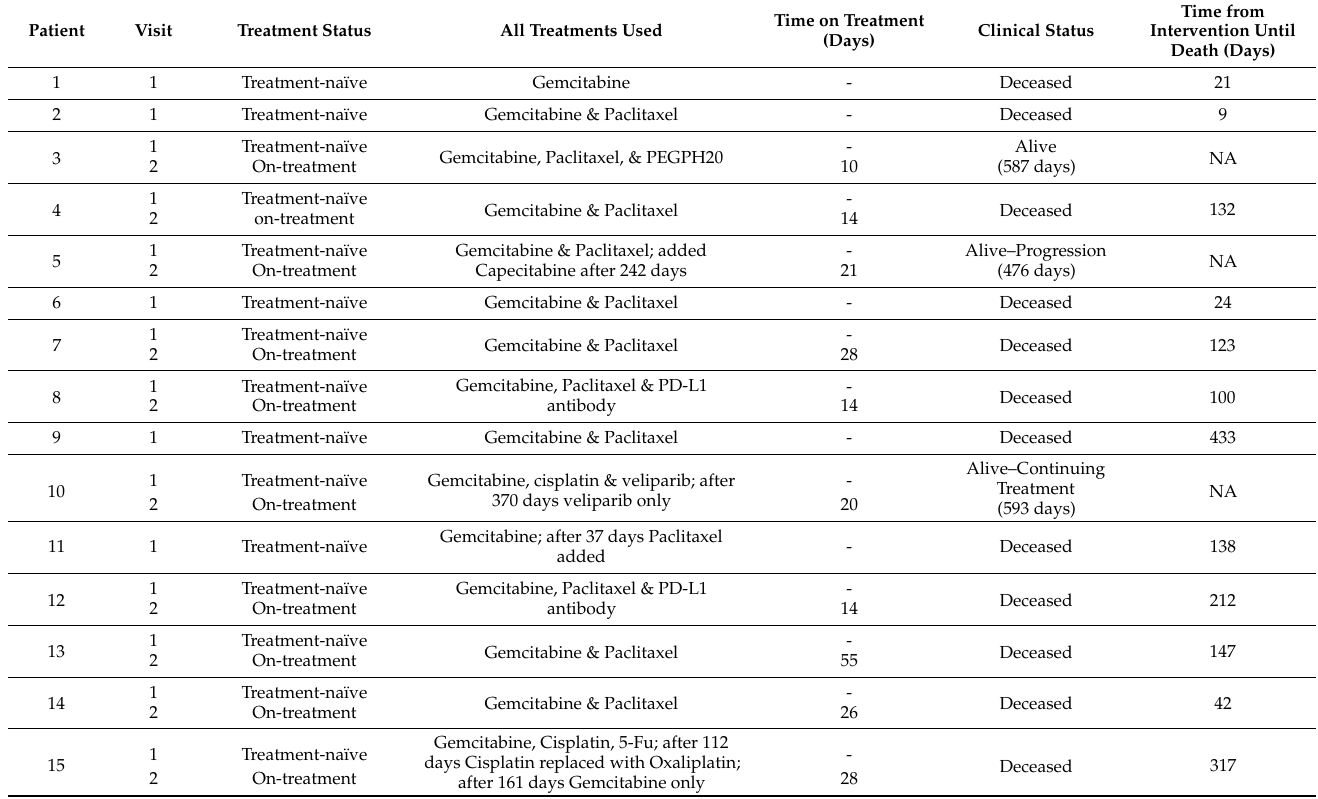
Table 2. Patient Treatment and Clinical